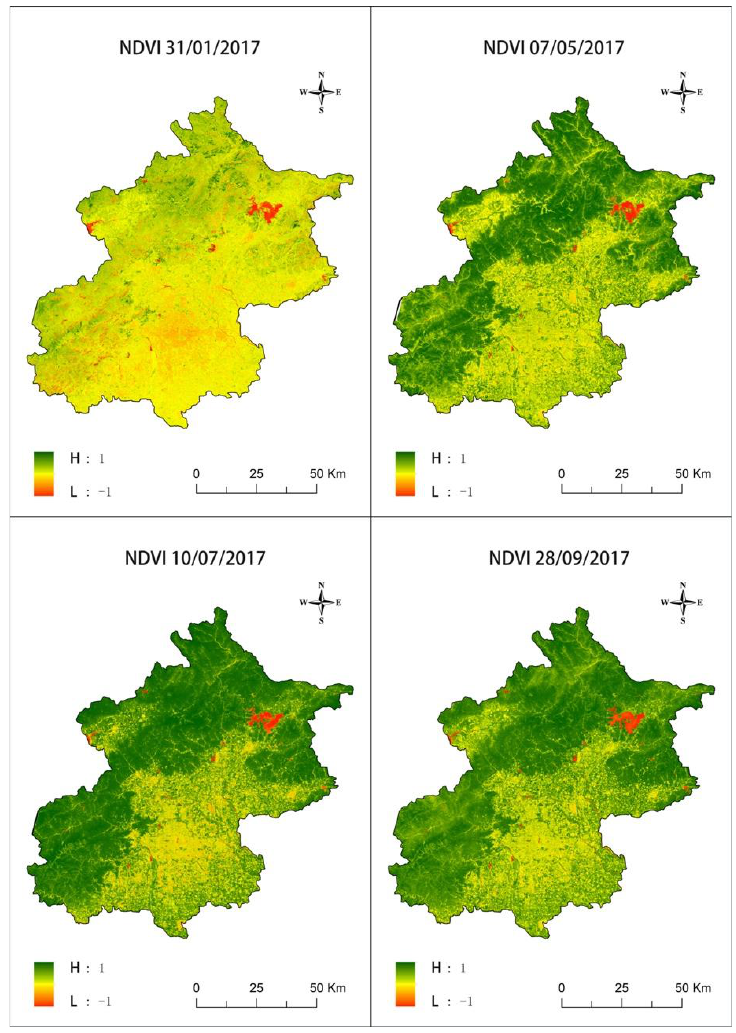
Figure 2. The NDVIs of Beijing: 31 January 2017, 7 May 2017, 10 July 2017, and 28 September 2017.